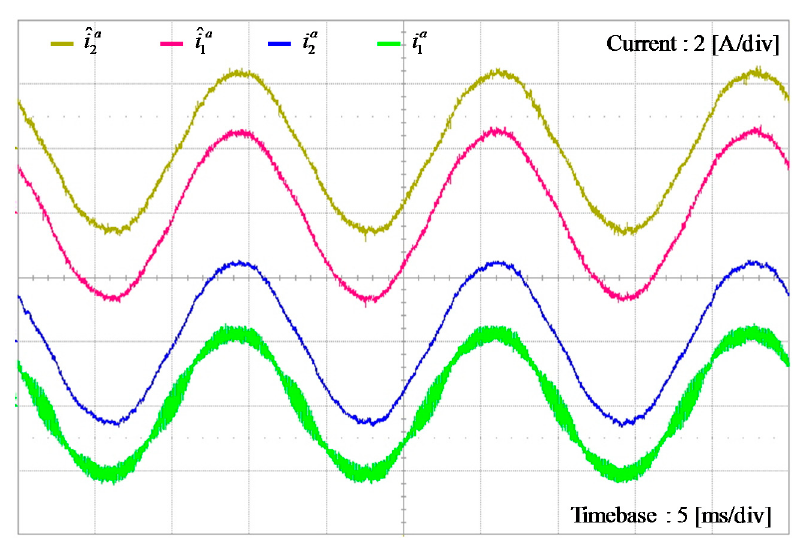
Figure 14. Experimental results for the measured and estimated waveforms of a -phase grid-side current and inverter-side current.